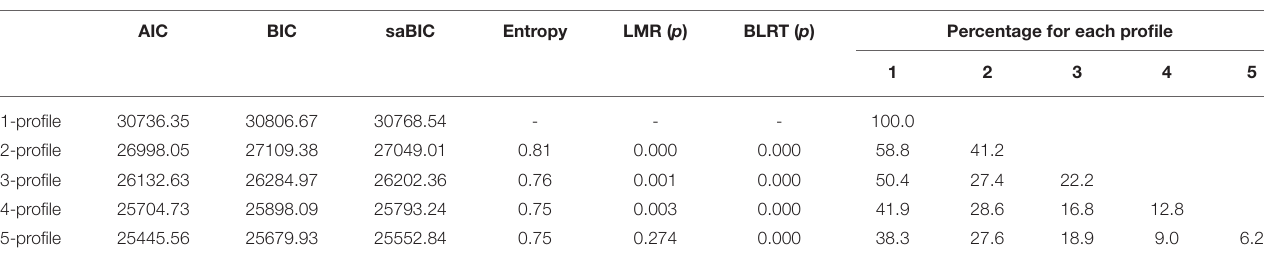
TABLE 4 | A latent profile analysis to identify risk profiles of Korean